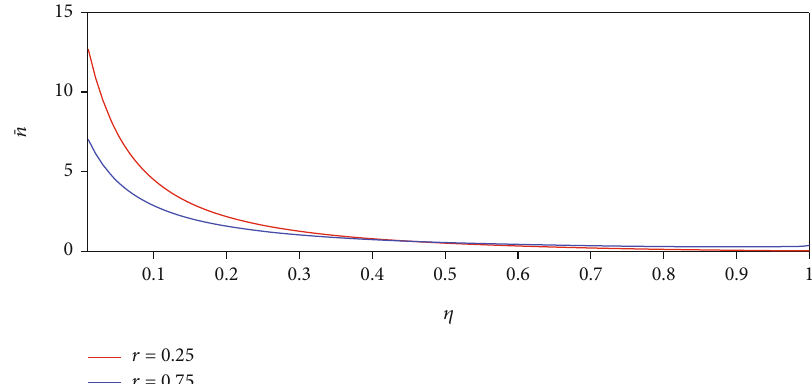
Figure 4: Plots of the mean photon number (Equation (27)) versus η for A = 100 and κ = 0 : 8 and for di ff erent values of squeeze parameter.